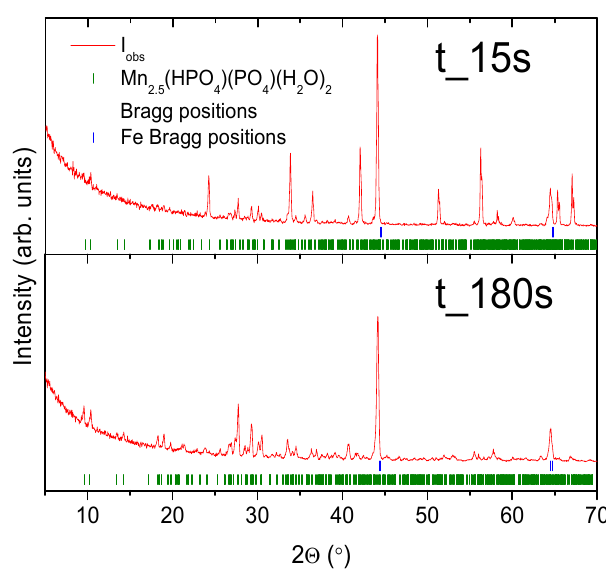
Figure 3. XRD patterns for the samples t_15s and t_180s. Solid red lines are the measured patterns, the green tickmarks correspond to the Mn 2.5 (HPO 4 )(PO 4 )(H 2 O) 2 phase, and the blue tickmarks correspond to iron.